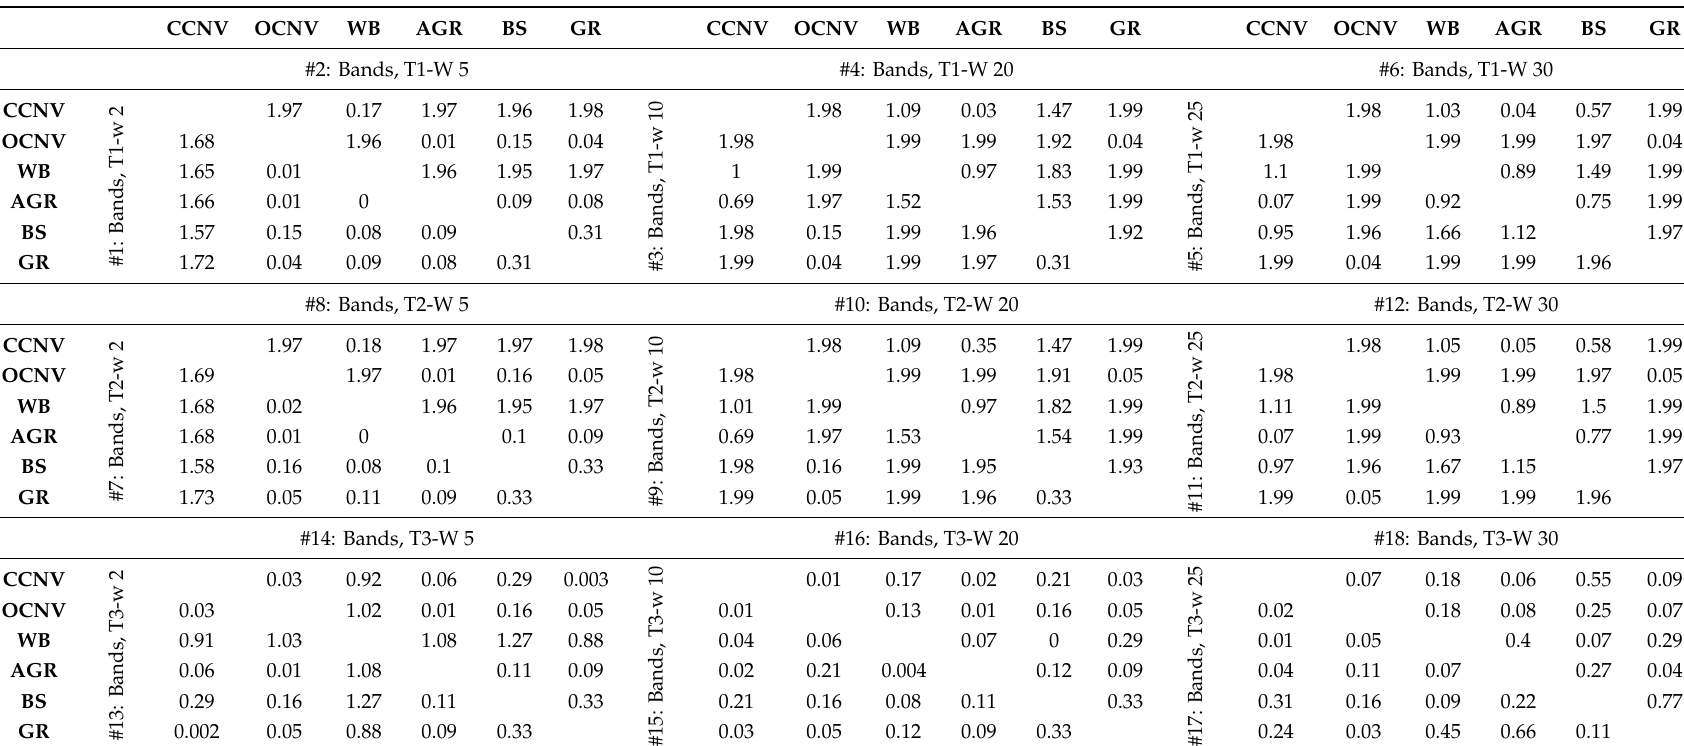
Table 5. Je ff reys–Matusita distance for all possible pairs of classes as assessed for di ff erent feature